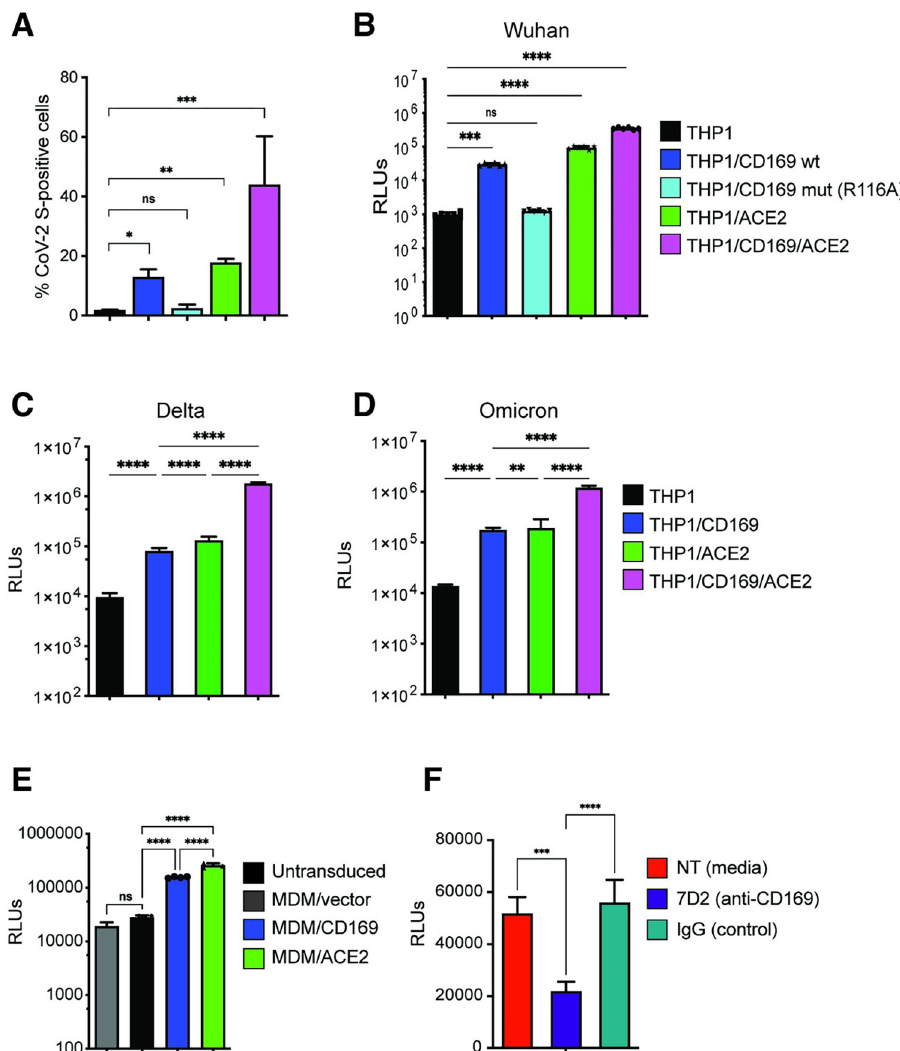
Fig 2. CD169 is a SARS-CoV-2 attachment and entry factor in macrophages. ( A ) Binding of SARS-CoV-2 S protein (Wuhan isolate) to THP1 monocytes expressing wt CD169, mutant CD169 (R116A), ACE2, or both wt CD169 and ACE2 (CD169/ACE2). ( B ) THP1/PMA macrophages were infected with Wuhan ( B ), Delta ( C ) or Omicron ( D ) S- pseudotyped lentivirus (20 ng p24 Gag ). Infection was quantified by measuring luciferase activity at 3 dpi. Relative light units (RLUs) from each cell line were normalized to no virus control (mock). The means ± SEM are shown from at least five independent experiments. ( E ) Primary MDMs from three donors overexpressing either CD169 or ACE2, or vector control were infected with Wuhan S-pseudotyped lentivirus (20 ng p24 Gag ) for 3 days, followed by analysis of luciferase activity in whole cell lysates. ( F ) Untransduced primary MDMs (representative of 3 donors) were pre-treated with anti-CD169 mAb (20 μ g/ml, 7D2), IgG1, or left untreated (NT) for 30 min at 4˚C prior to infection with Wuhan S-pseudotyped lentivirus (20 ng p24 Gag ) for 3 days, followed by analysis of luciferase activity. RLUs from each donor in each group were normalized to no virus control (mock). The means ± SEM from 3 independent experiments are shown. P -values: paired t-test, two-tailed ( A ), one-way ANOVA followed by the Dunnett’s post-test ( B ) or Tukey’s post-test comparing to untransduced cells ( C - E ), or each pre-treatment condition ( F ). �� : p < 0.01; ��� : p < 0.001; ���� : p < 0.0001; ns: not